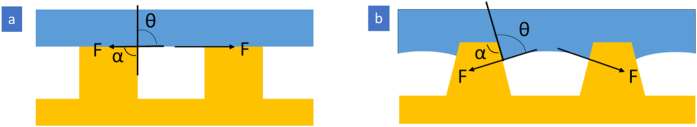
Schematic diagrams (not to scale) illustrating possible solid-liquid-vapour interfaces with the same equilibrium contact angle (θ), but different geometric angles (α).(a) θ ≈ α and (b) θ < α.